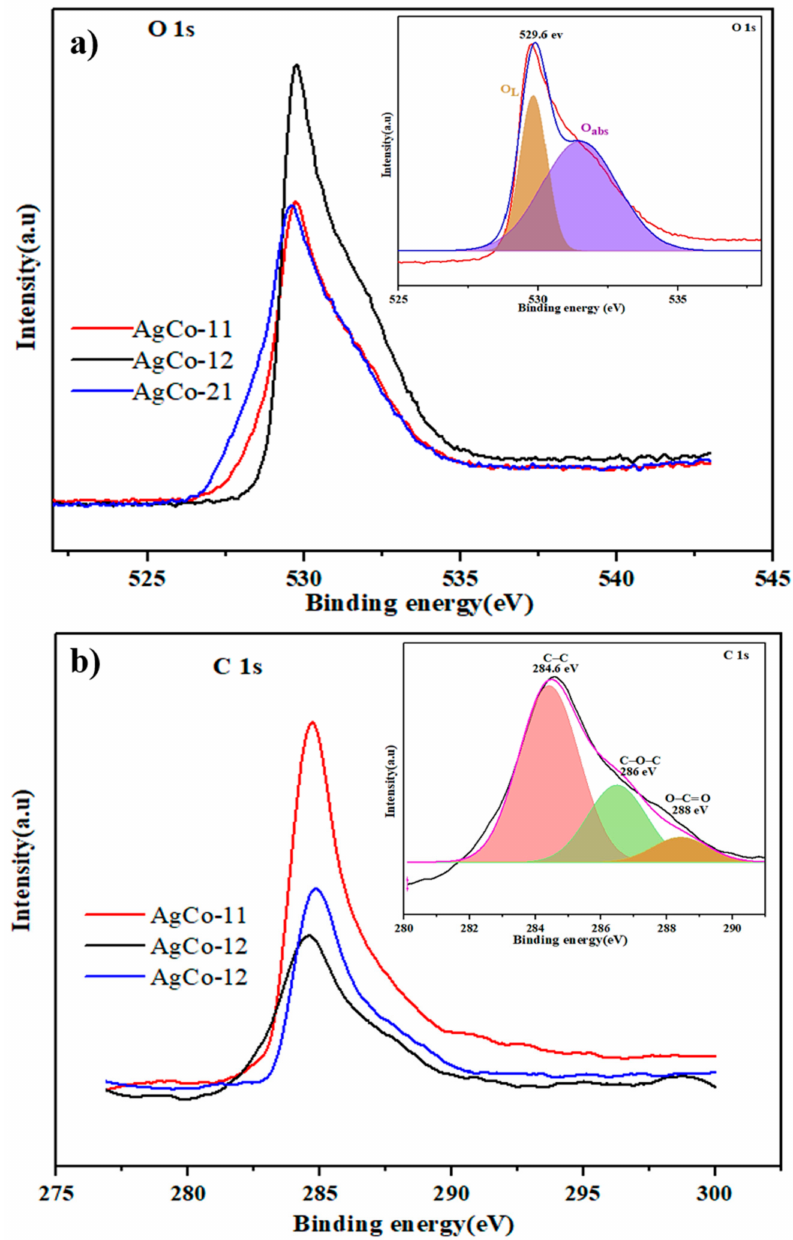
Figure 9. XPS spectrum of ( a ) O 1s ( b ) C 1s of three samples of Ag-Co. Inset shows the corresponding deconvoluted